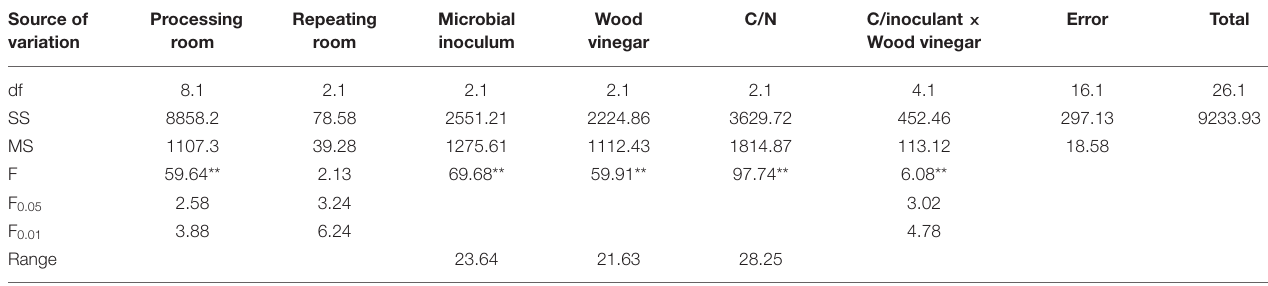
TABLE 7 | Analysis of variance of orthogonal test. Source of variation